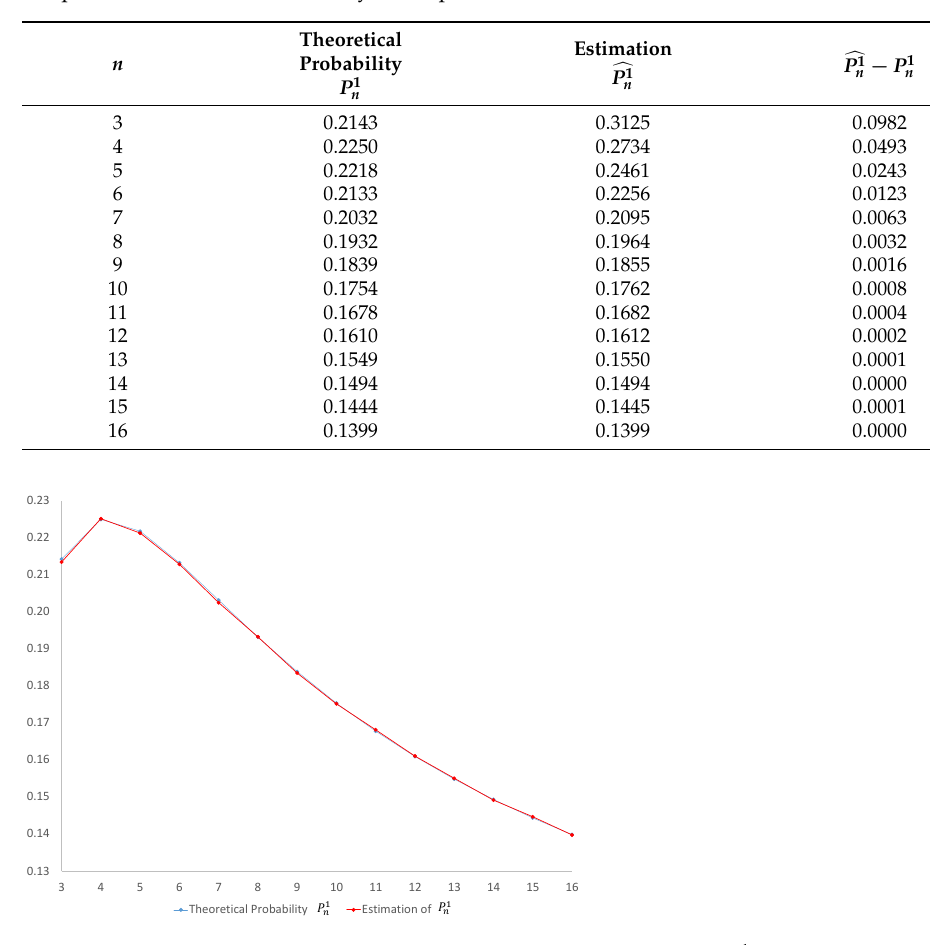
Table 6. Comparison between the Theoretical Probability P 1 n of falling into the same Hamming Weight class after a random swap with its estimate (cid:100) ( P 1 n ) obtained using M = 1,000,000 successive swaps made from a fixed, arbitrary initial permutation.